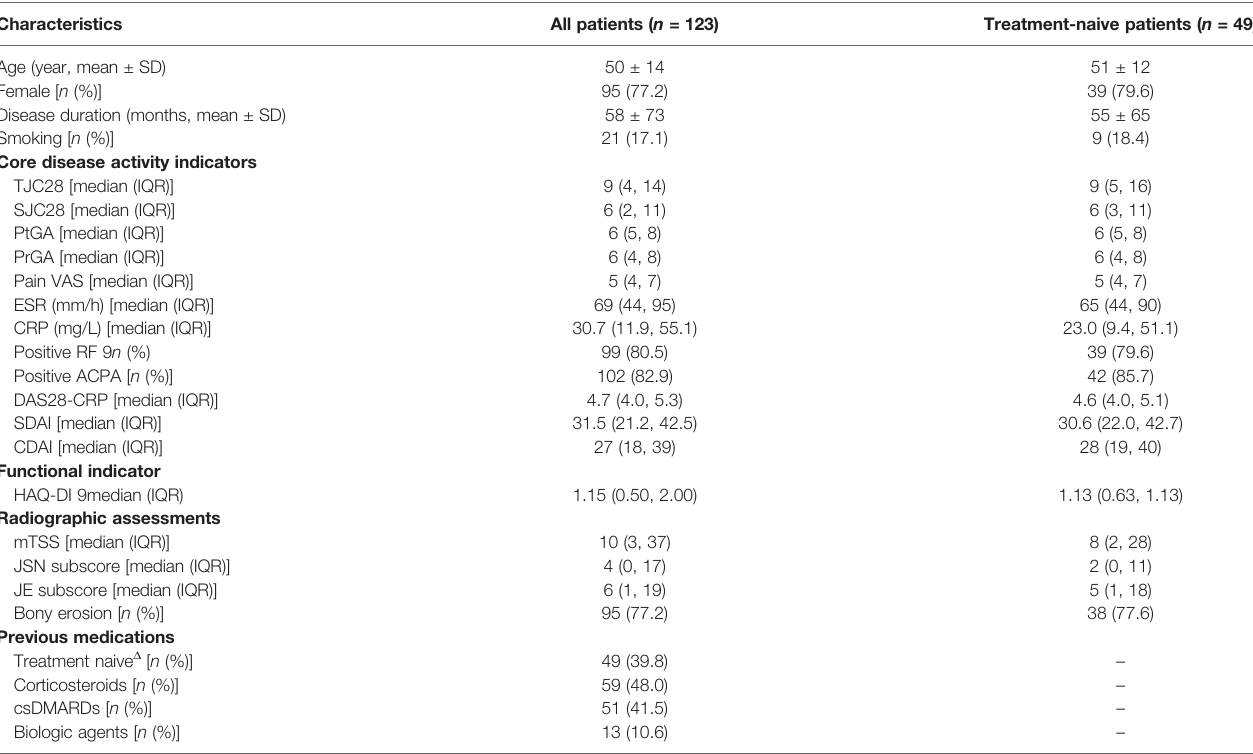
TABLE 1 | Baseline characteristics of included RA patients.